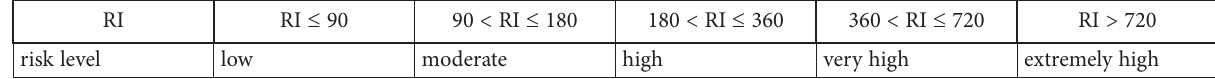
Table 2. Classes of potential ecological